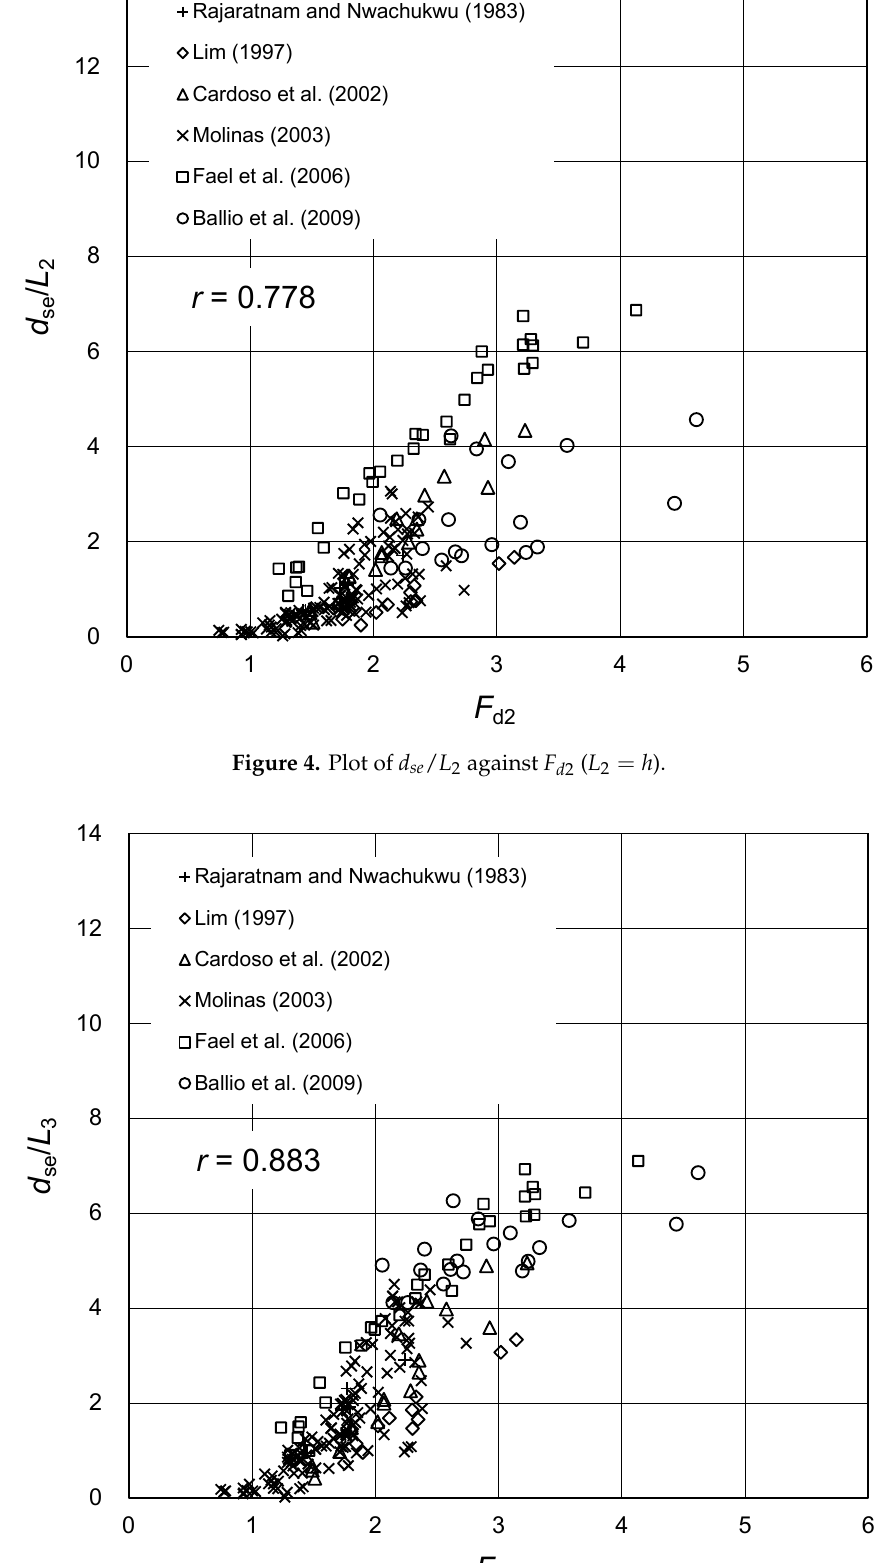
Figure 5. Plot of d se / L 3 against F d 2 [ L 3 =